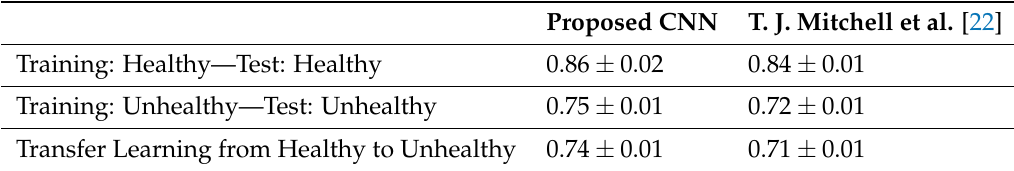
Table 4. Comparison of the proposed model with the alternative